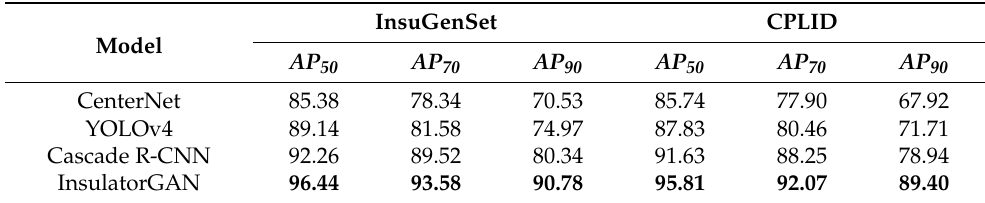
Table 4. APs of the different